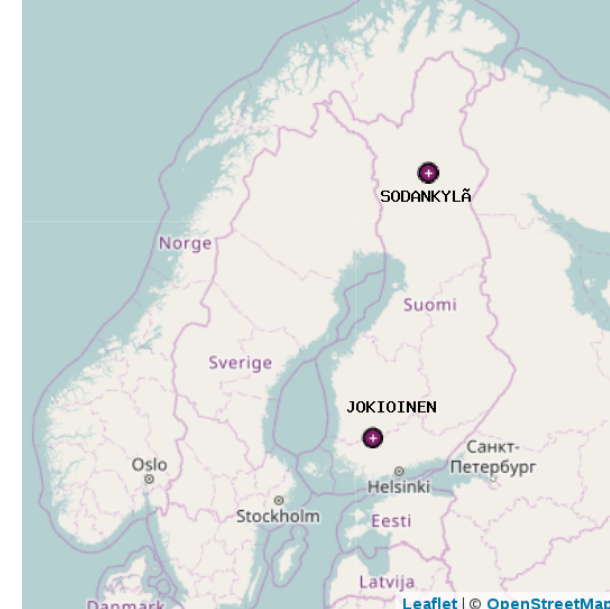
Figure 4. Location of the Finnish Meteorological Institute Jokioinen and Sodankylä